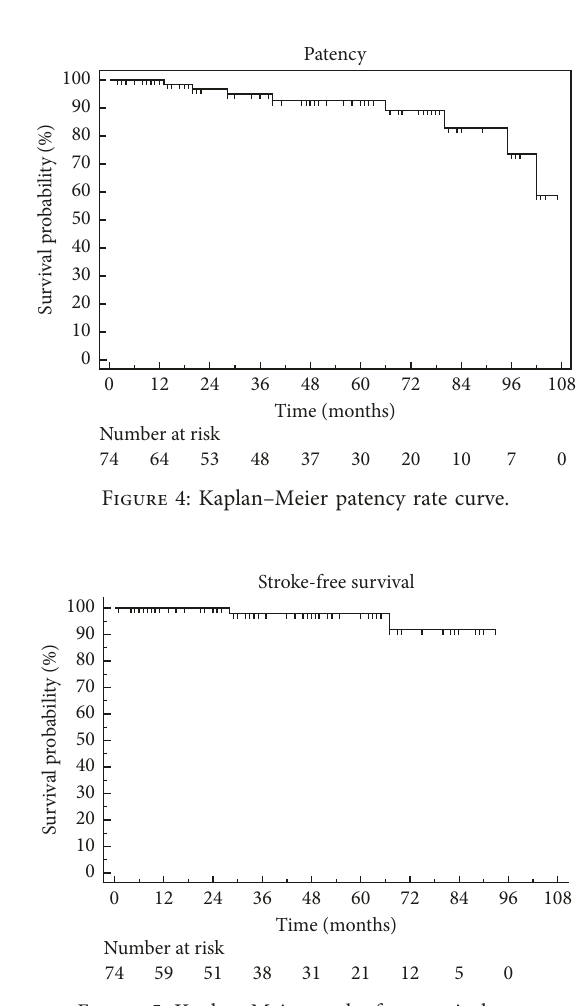
Figure 5: Kaplan–Meier stroke-free survival rate.